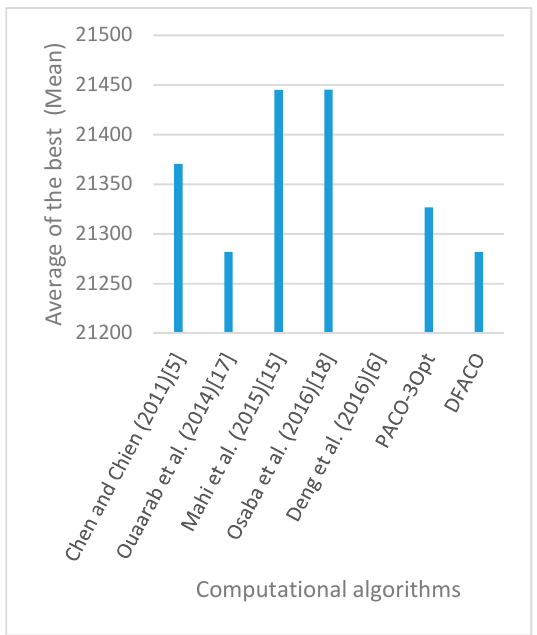
Figure 18. Average of best solutions obtained for instance kroA100 by all algorithms.